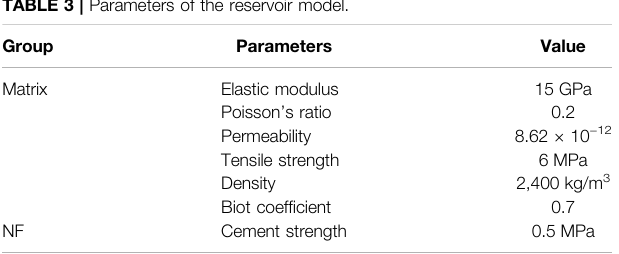
TABLE 3 | Parameters of the reservoir